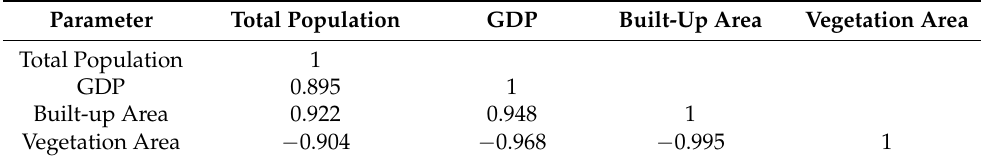
Table 7. Correlation coefficient matrix of four parametric